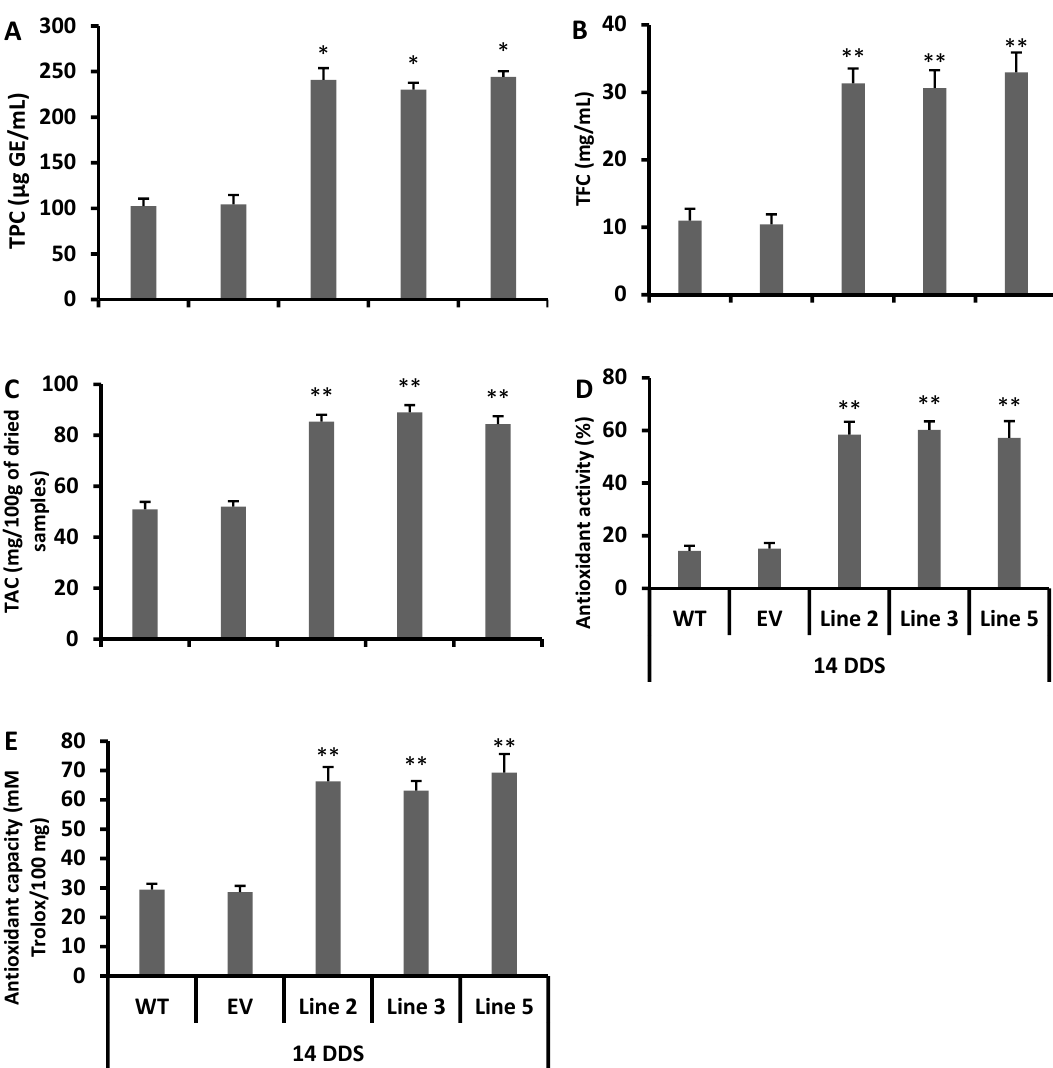
Figure 5. Various metabolic and antioxidant-related parameters. ( A ) Total phenolic contents (TPCs). ( B ) Total flavonoid contents (TFCs), ( C ) Total anthocyanin contents (TACs). ( D ) Antioxidant activity ( E ) Antioxidant capacity. 14DDS: after 14 days of drought stress. WT: wild type. EV: empty vector. A Students t -test was used to compare the CYT-OX and WT plants at * p < 0.05 and ** p < 0.01. Each